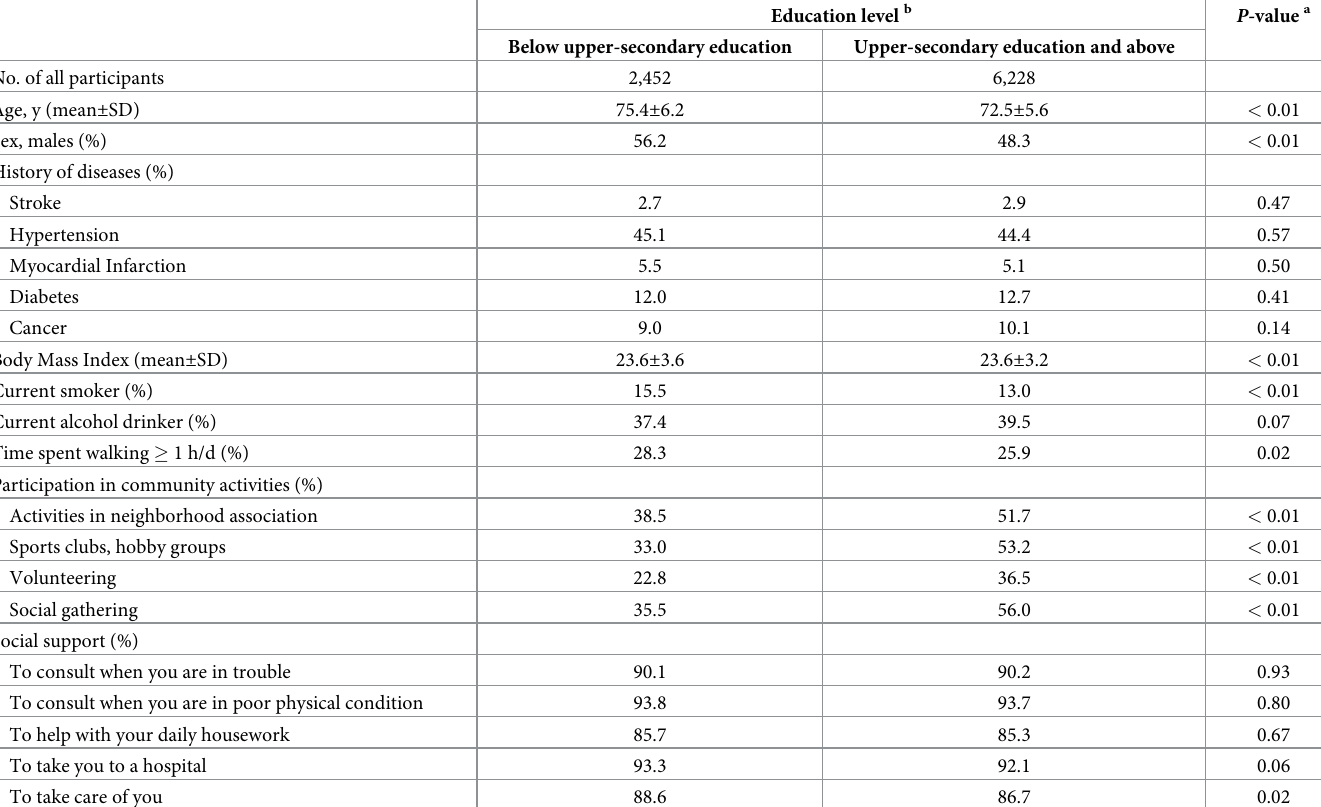
Table 1. Baseline characteristics of the participants according to education level (n = 8,680). Ohsaki city, Japan,